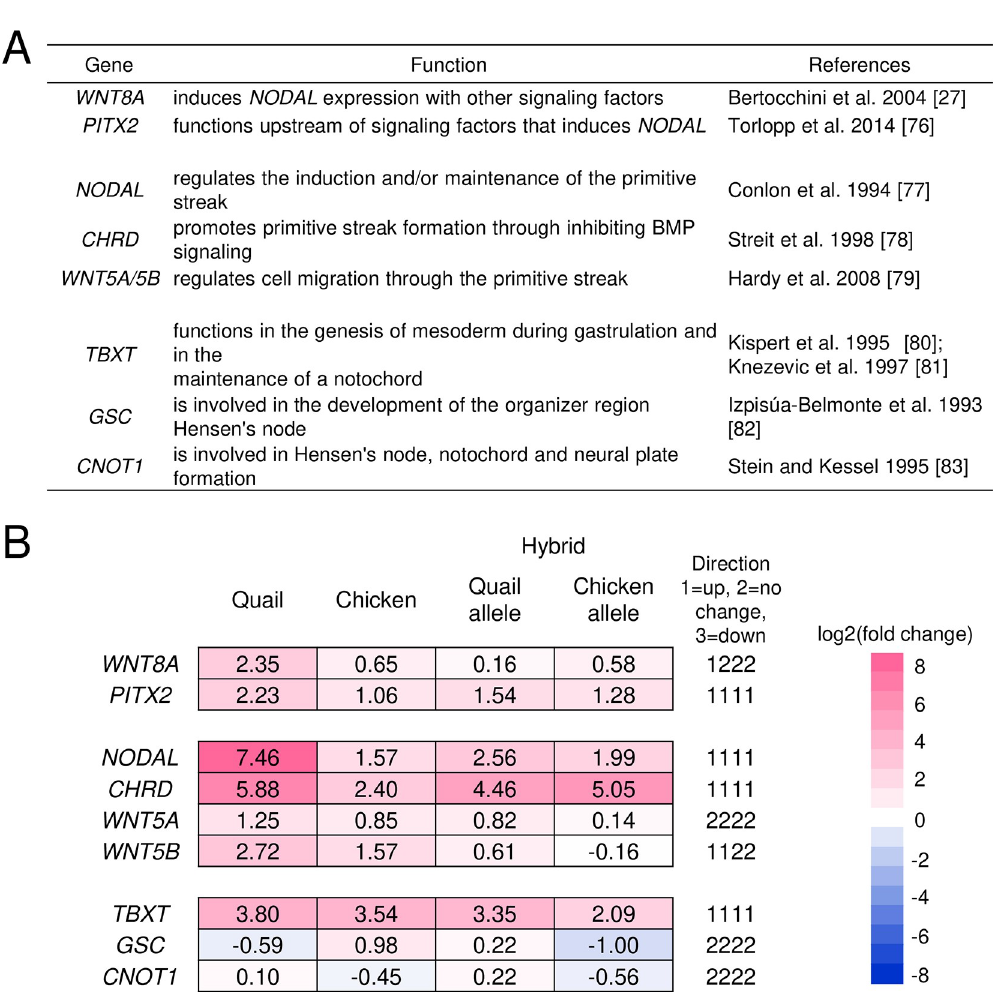
Fig 7. Expression changes of primitive streak formation-related genes. Genes that function before ( WNT8A and PITX2 ), during ( NODAL , CHRD , and WNT5A/5B ), and after ( TBXT , GSC , and CNOT1 ) the formation of the primitive streak (A) and changes of their expression from the stage X to the stage XIII/XIV in male embryos (B). Four-digit numbers shown on the right side of the column indicate the direction of expression changes in quail, chickens, and their hybrids (quail- and chicken-derived alleles), respectively. Only WNT5B displays the pattern D of gene expression. Color scale on the far right shows the degree of gene expression